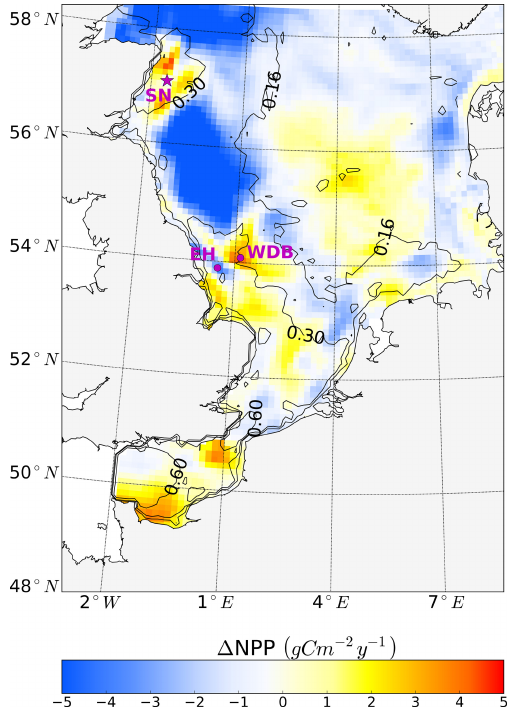
Figure 9. Simulated annual mean NPP difference between the tidal (M 2 + S 2 ) and M 2 scenarios, averaged for 1990–2015. Positive val- ues depict higher NPP values in the tidal scenario (M 2 + S 2 ) than in the M 2 scenario. Contour lines indicate the estimated mean spring– neap cycle range of the tidal current speed difference between the tidal (M 2 + S 2 ) and M 2 scenarios. The two magenta dots indicate the locations of two characteristic grid cells. One grid cell is close to the Estuary of Humber (EH), and the other grid cell is located more offshore at the western edge of Dogger Bank (WDB) (see Fig. 10). The magenta star shows the location of the grid cell (SN site) used for the analysis of the advancement and delay of the spring bloom due to spring–neap tidal forcing (see Fig.